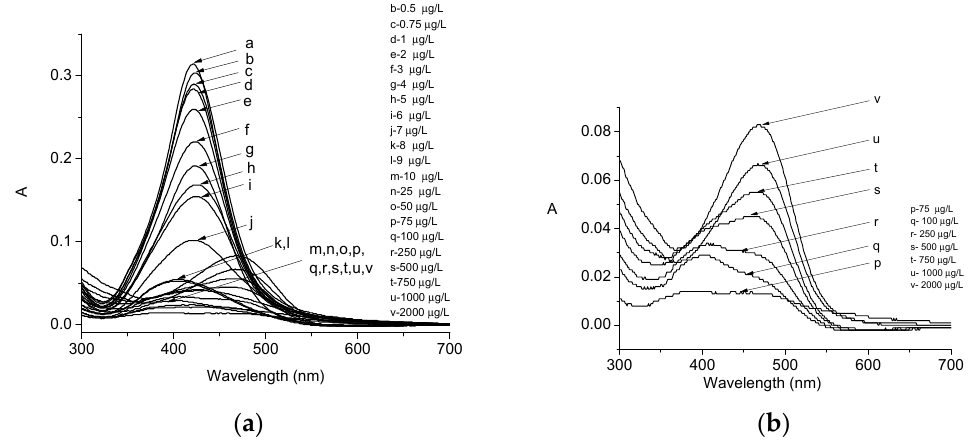
Figure 3. ( a ) LSPR spectra of colloidal AgNPs after addition of Pb 2+ at different concentrations in the presence of dithizone, ( b ) Zoomed area with selected concentrations of Pb 2+ .